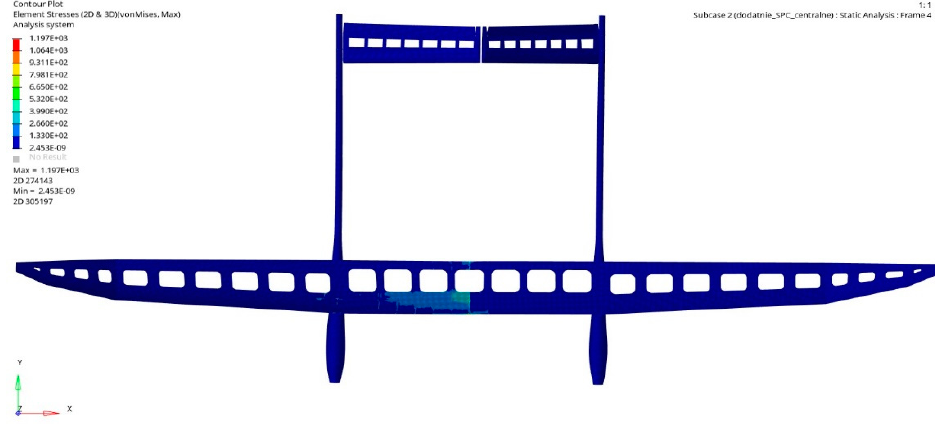
Figure 17. Global stress plot.